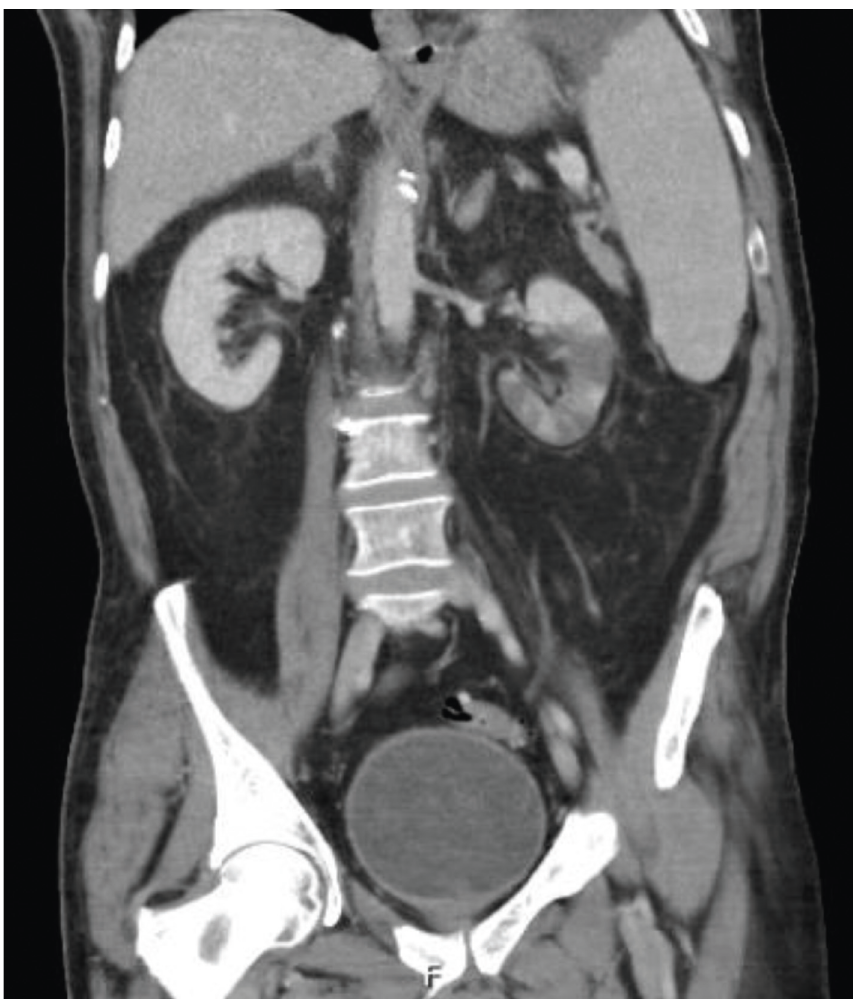
Figure 2: Coronal view of CT abdomen and pelvis showing numerous hypodensities of the interpolar region and lower pole of the left kidney consistent with